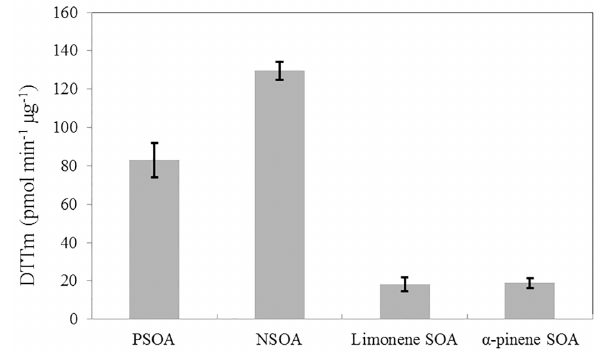
Figure 2. DTT m (pmolmin − 1 µg − 1 ) for SOA formed from various types of hydrocarbons (phenanthrene, naphthalene, limonene, and α -pinene). Each measurement was conducted in triplicates, and the error bar represents the standard error of the mean